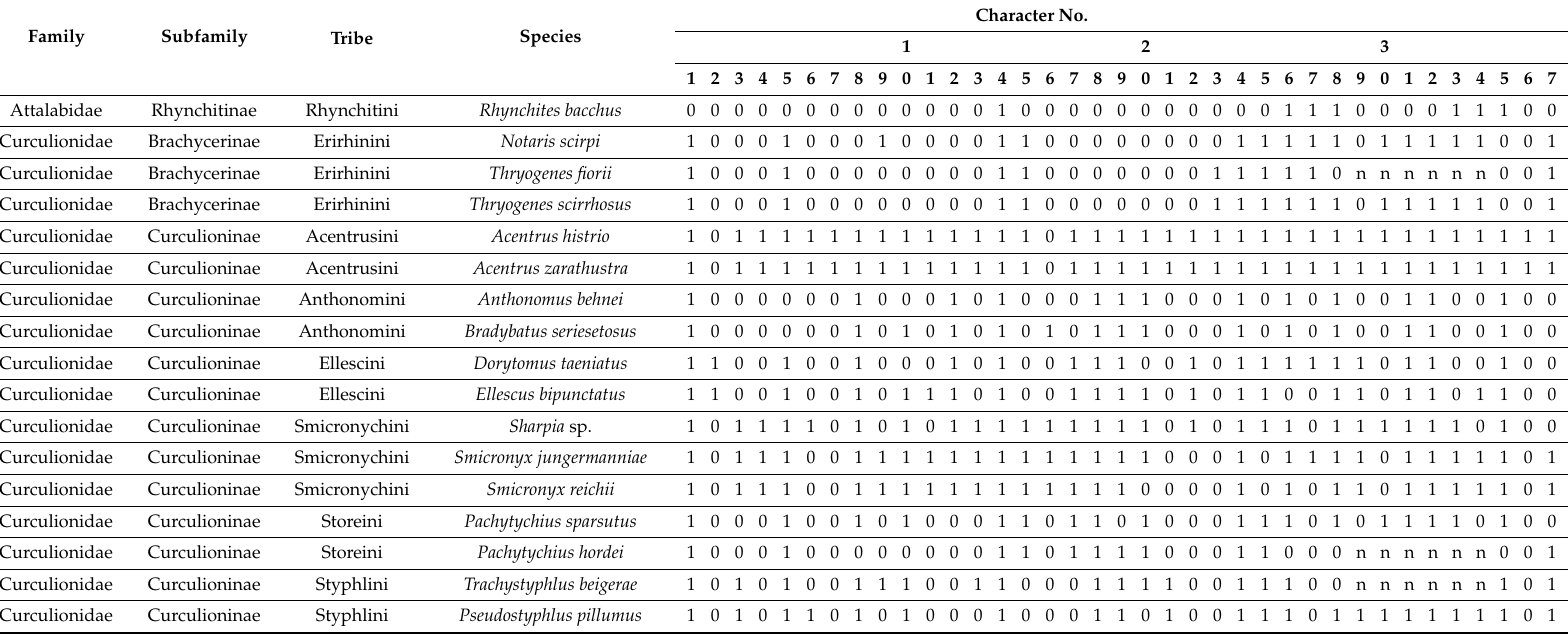
Table 1. Character matrix of tribes of the family Curculionidae ordered alphabetically and one outgroup species of the family Attelabidae. Family Subfamily Tribe Species